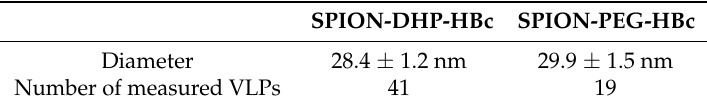
Table 2. VLPs diameter measurements obtained from transmission electron microscopy (TEM) images. Measured with ImageJ